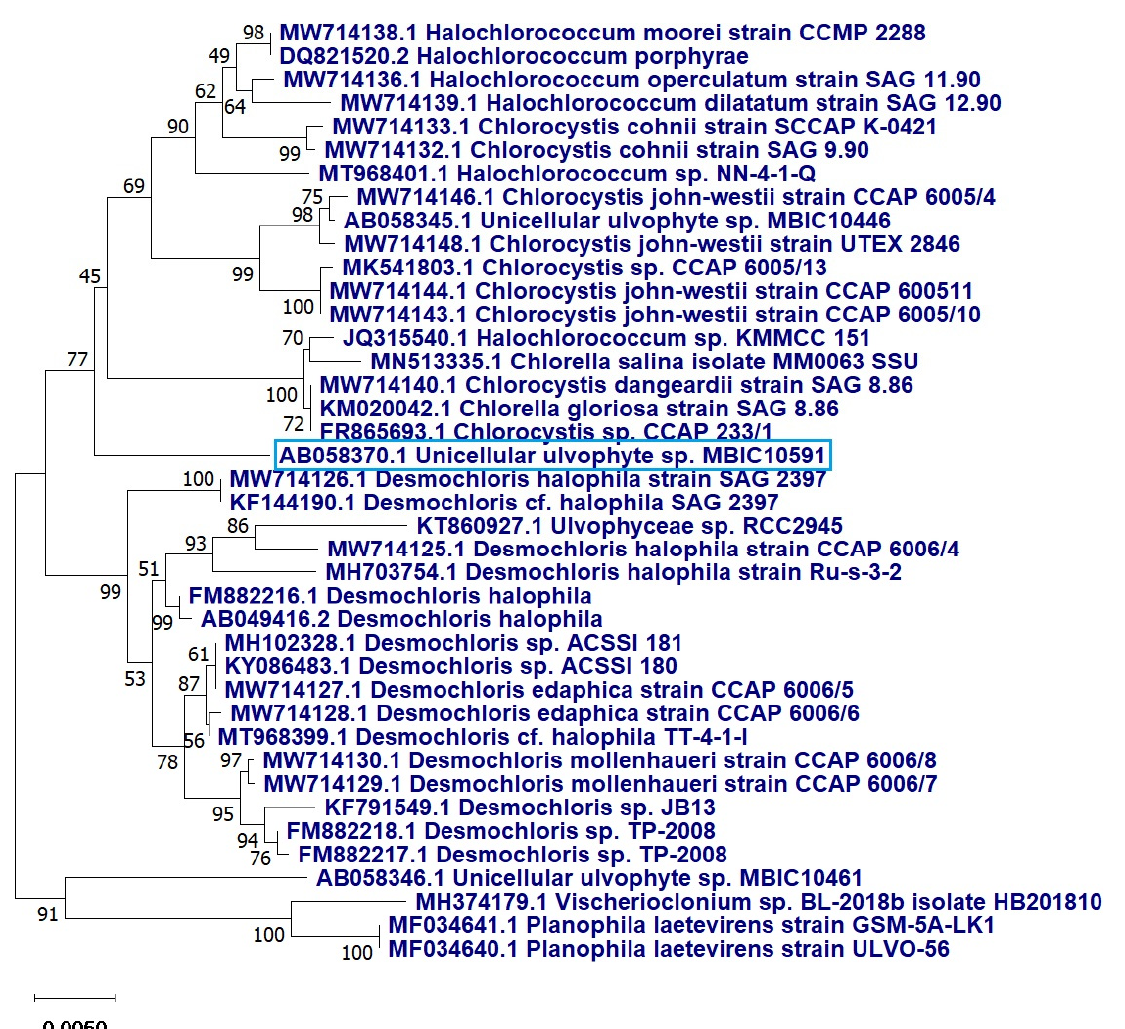
Figure 3. Phylogenetic tree of the unicellular ulvophyte sp. MBIC10591 (blue frame) inferred from 18S r RNA. Tree was constructed by cluster method using MEGA4 software version 10.2.6. Number at each branch refers to the bootstrap values for % of 1000 replicate trees calculated by neighbour joining statistical method.